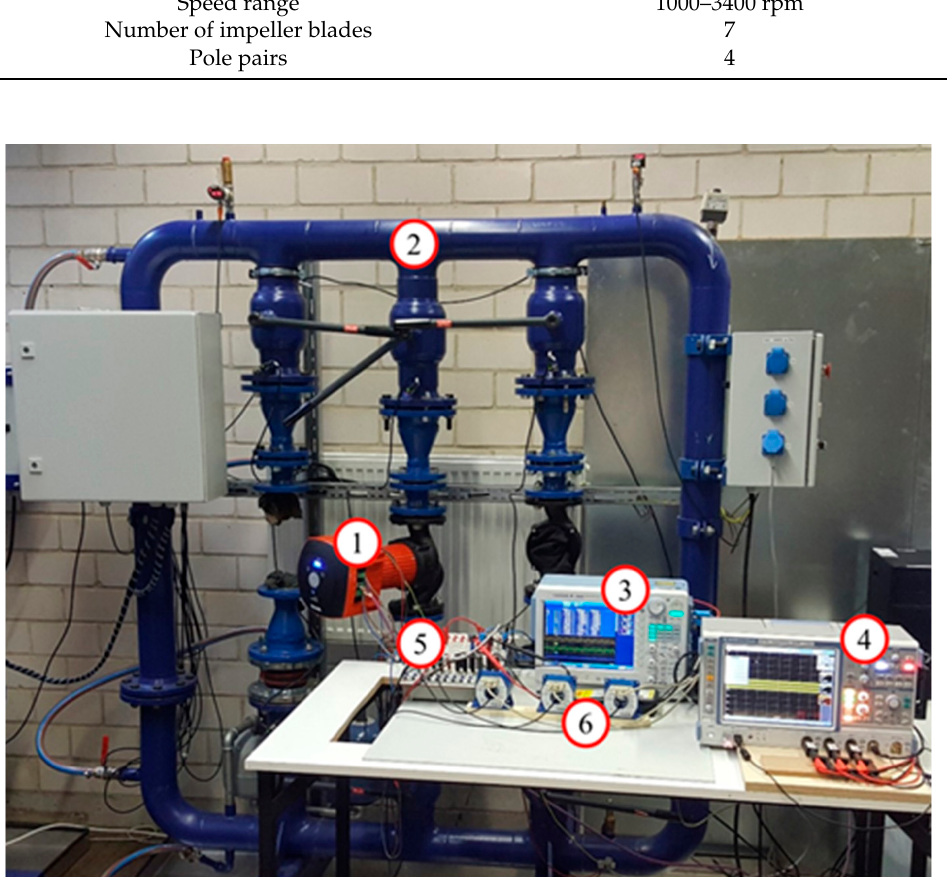
Figure 3. PMSM test bench for eccentricity fault emulation. (1) PMSM, machine under study, (2) piping system, (3) power analyzer, (4) waveform recorder, (5) acquisition board and (6) current sen- sors. Table 7. Main characteristics of the pump.